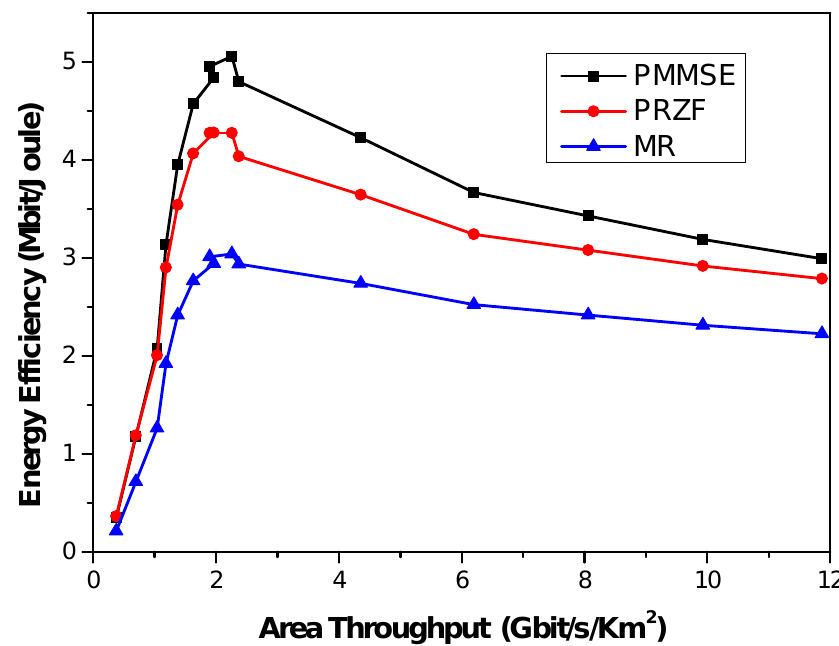
Figure 7. Energy efficiency as a function of area throughput for different receive combining